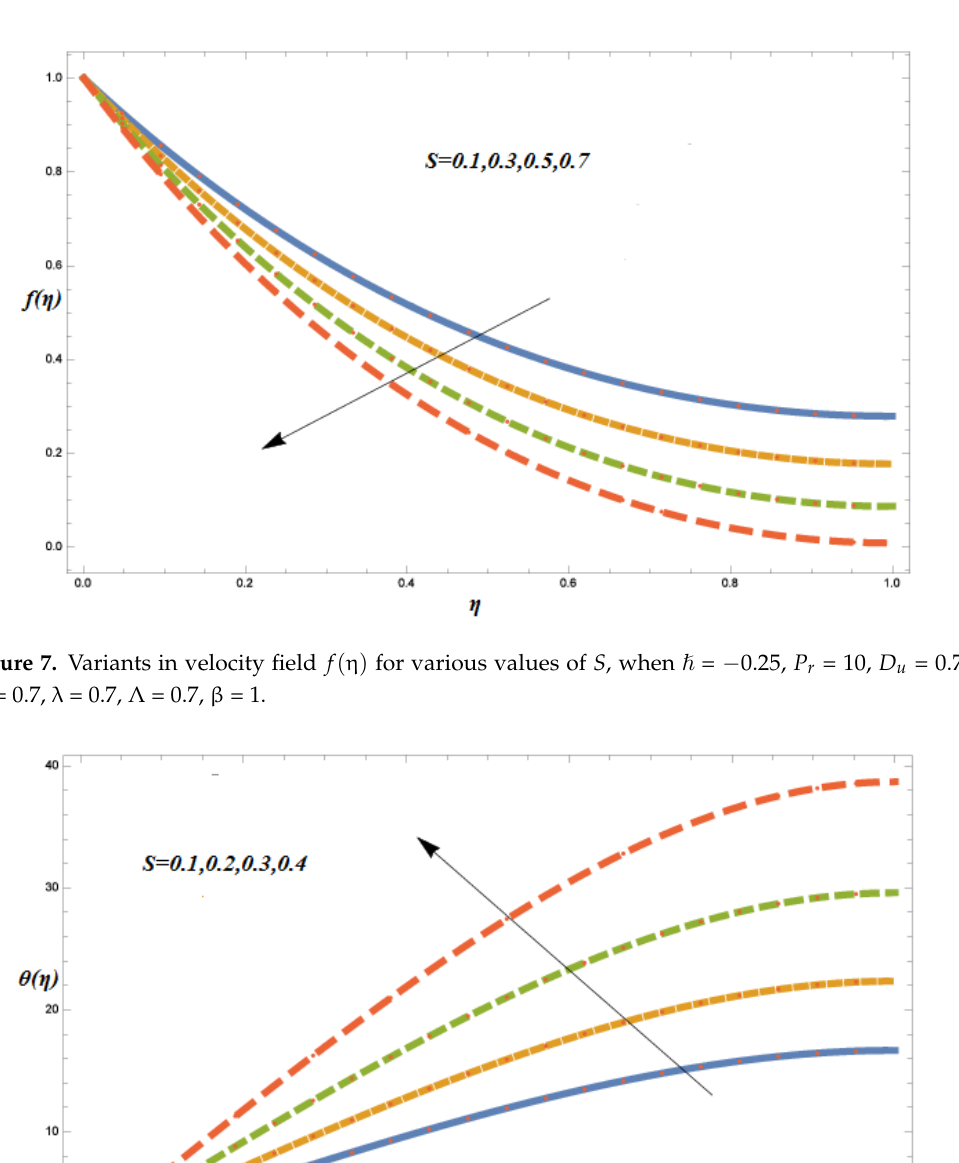
Figure 6. The comparison between HAM and numerical solutions for concentration fields ( )   , when  = − 0.25, P r = 10, B r = 0.1, N r = 0.1, D u = 0.1, S c = 0.1, ε = 0.1, S r = 0.1, λ = 0.1, Λ = 0.1, β = 1, S = 0.1.